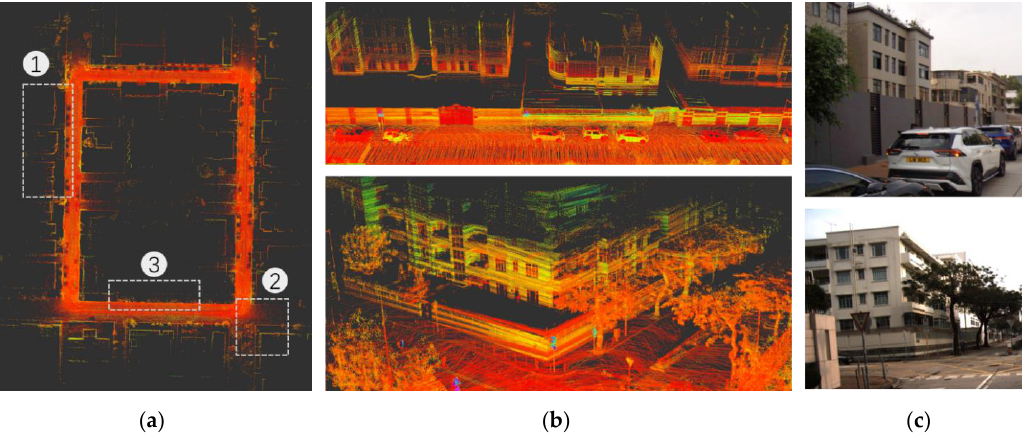
Figure 11. The map is generated by LC-LIO-AC in the urban canyon 1 and rendered with intensity value. ( a ) The entire map in bird-eye view. ( b ) The top panel is the zoomed-in map around the first place marked in ( a ), the bottom panel is the zoomed-in map around the second place marked in ( a ). ( c ) The top and the bottom panels are the environments that correspond to the first and the second place, respectively.